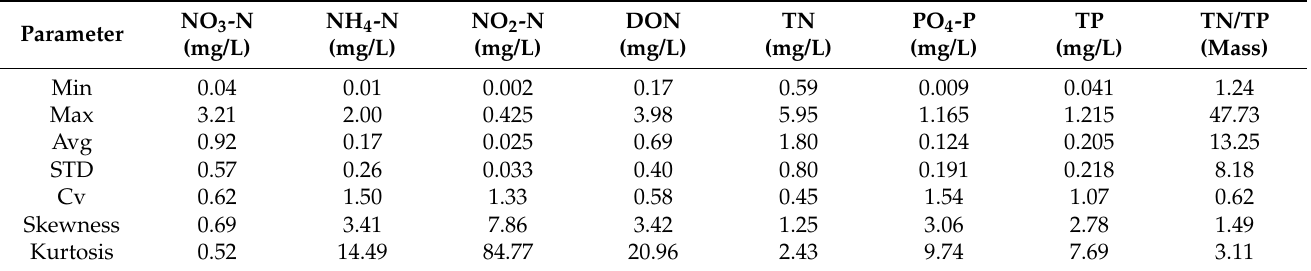
Table 3. Descriptive statistics of N and P concentrations in examined water